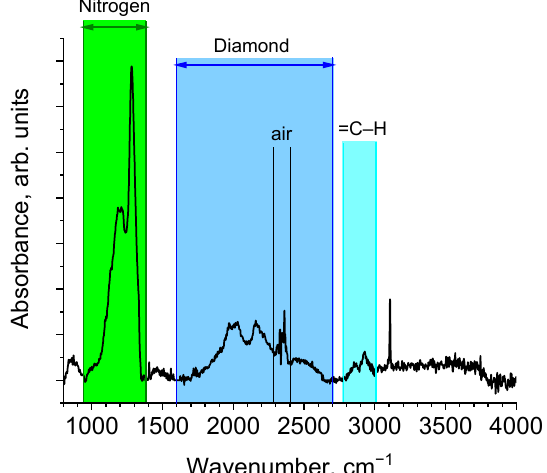
Figure 13. IR spectrum for the sample SEu3. The ranges of wavenumbers related to various nitrogen defects (Table 3) and other absorption centers in diamonds are shown. Table 3. Concentration of nitrogen defects according to FTIR data.